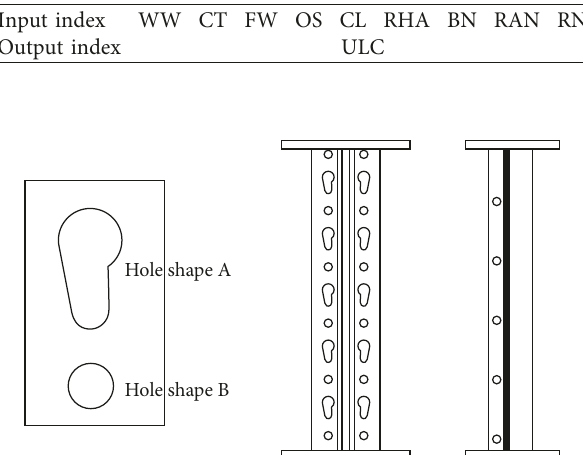
Figure 12: Holes’ pass and distribution of M90A series column.